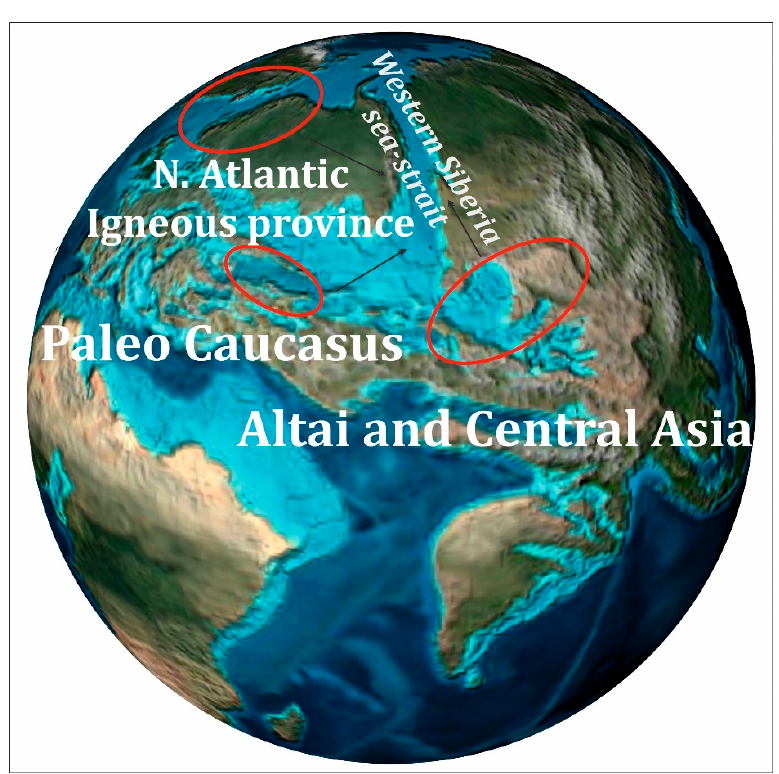
Figure 8. Eocene Northern Hemisphere configuration. NAIP—North Atlantic igneous province (as a possible pyroclastic material source).